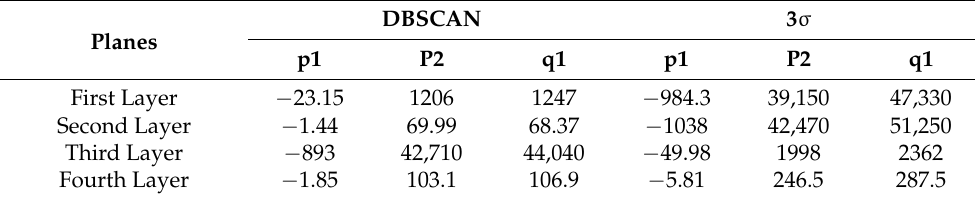
Table 3. Model parameters of grain temperature correlation coefficient threshold on the XOZ plane. Planes